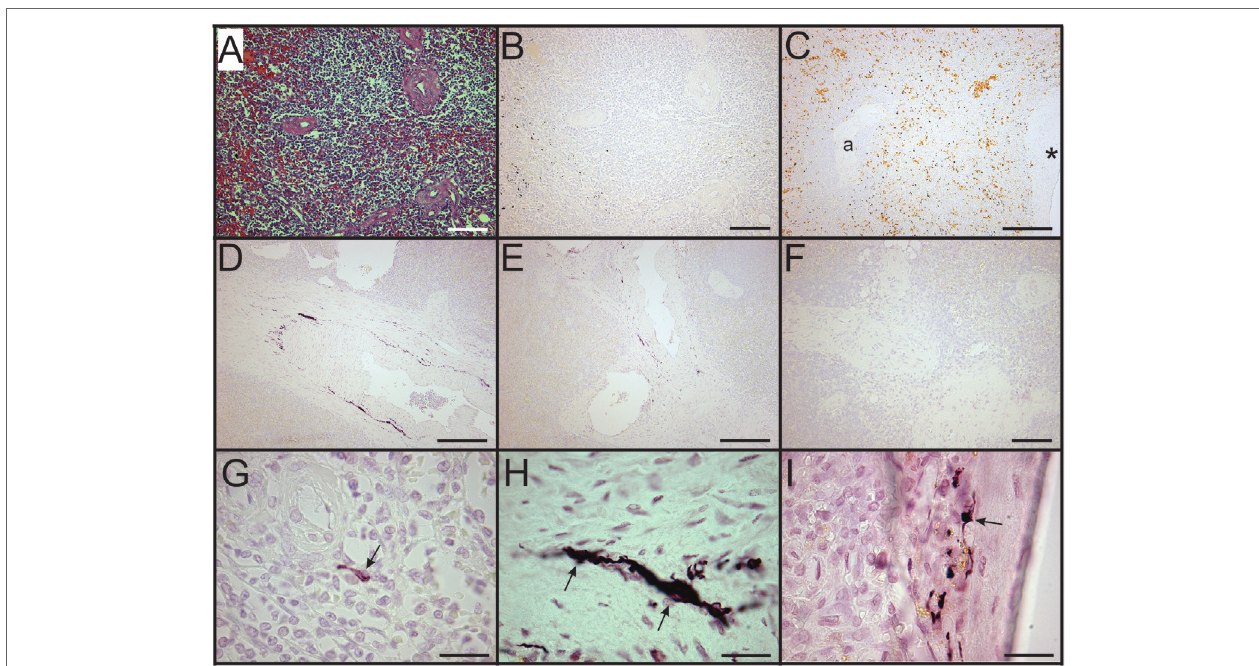
FigUre 4 | Loss of sympathetic nerves in spleens from patients who died with sepsis. (a,b) Hematoxylin and eosin stain (a) and tyrosine hydroxylase (TH) stain (b) of spleen section from 63-year-old male. Note absence of TH + nerve fibers around arteries. (c) Absence of TH + nerves around large artery (*) and smaller artery (a) in spleen section from an 87-year-old female patient. Sections from both of these patients lacked sympathetic nerves. (D–F) Images showing reduced abundance of periarterial TH + nerve fibers in spleen from a 70-year-old female patient who died with sepsis. Large (D) and intermediate (e) diameter arteries show marked reduction of TH + nerve fibers compared to control patients and lacked large TH + nerve bundles. Smaller arteries (F) lacked TH + nerve fibers in this patient. (g) Solitary axon retraction ball in white pulp. (h) Tortuous reactive axonal profile with highly variable axonal diameter. (i) Axonal swelling where apparently intact axon profiles enter and leave zone of interrupted axonal transport. Scale bars: 100 µm (a,b,F) ; 250 µm (c–e) ; 25 µm (g–i) .